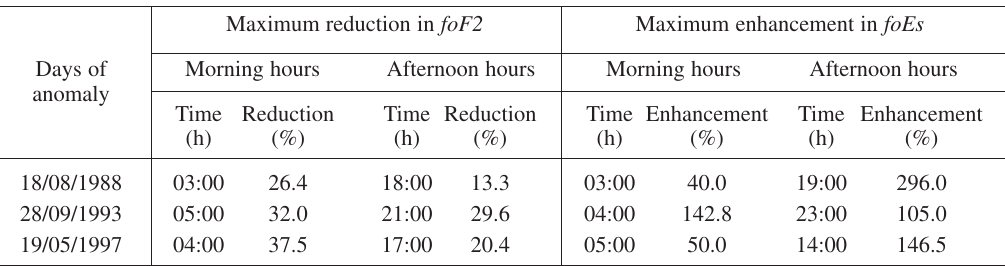
Table II. Details of times and maximum deviation of foF 2 and foEs observed during the anomalies. Maximum reduction in